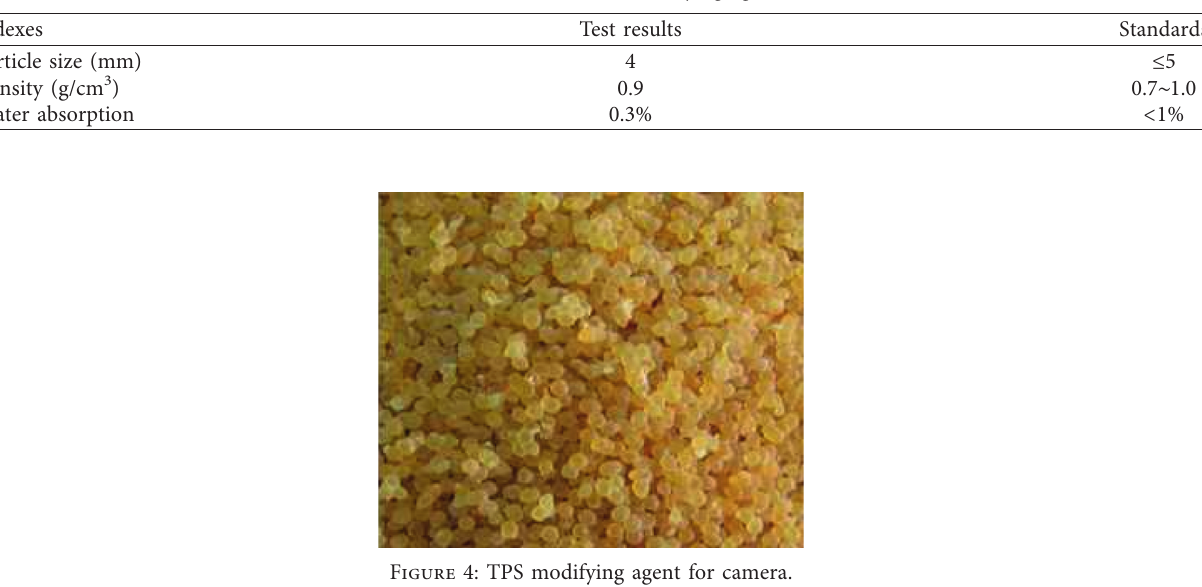
Figure 3: Index relationships of aging and regenerating asphalt. Table 6: Indexes of TPS modifying agent.